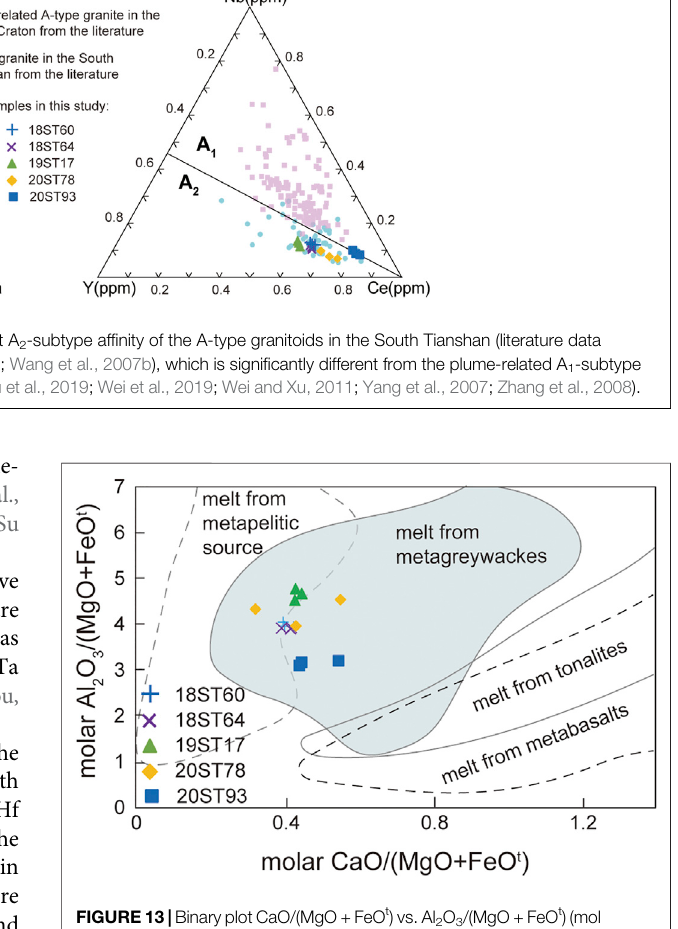
FIGURE13| BinaryplotCaO/(MgO+FeO t )vs.Al 2 O 3 /(MgO+FeO t )(mol %) (after Altherr et al., 2000) showing that the Permian granitic magma was mainly generated by the melting of meta -greywackes composed of arc- related volcanogenic sedimentary